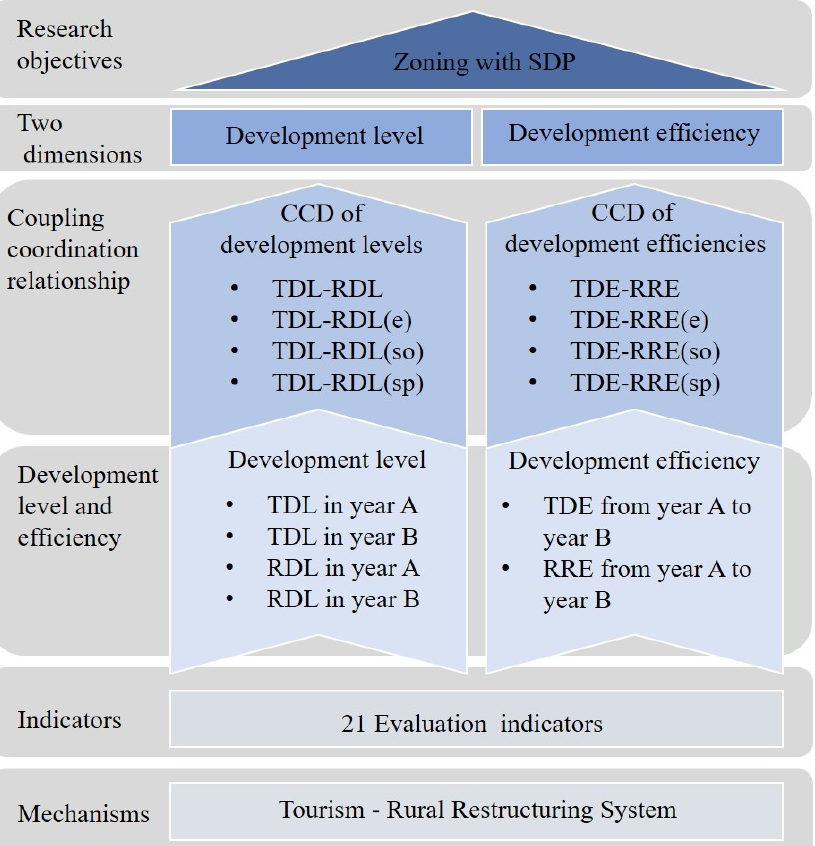
Figure 1. General framework of this study. RDL(e) is rural economic development level, RDL(so) is rural society development level, RDL(sp) is rural space development level, RRE(e) is rural economic restructuring efficiency, RRE(so) is rural society restructuring efficiency, RRE(sp) is rural space restructuring